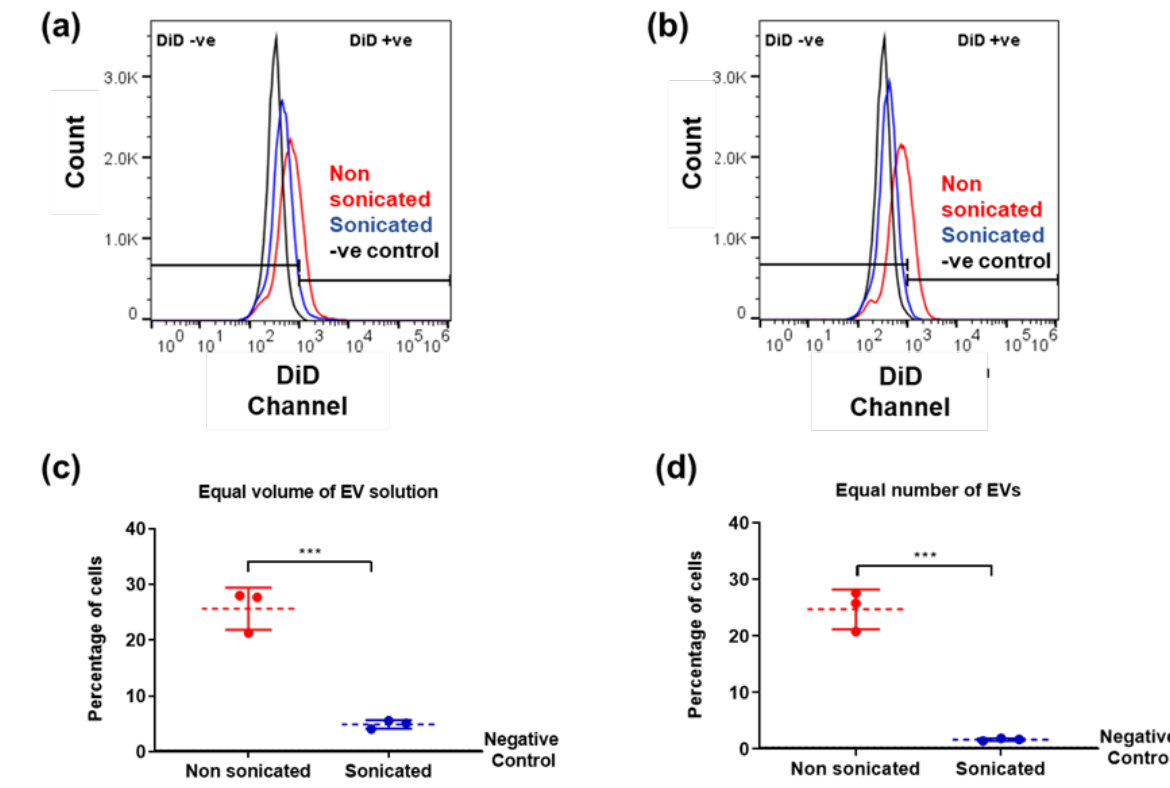
Figure 4. Flow cytometry analysis of EV uptake. DiD labelled EVs added at 0.5 µ L/cm 2 ( a , c ) or 1 × 10 9 particles/cm 2 ( b , d ). ( a , b ) Fluorescence detected in live cells after EV incubation compared to negative control (MSCs with no EVs added). ( c , d ) Quantification of cells containing EVs after incubation (red: non sonicated, blue: sonicated samples). Data analysis was performed with FlowJo v10.5 software (https://www.flowjo.com/) (accessed on 8 November 2018). N = 3, unpaired students t-test, two-tailed non-parametric; *** p < 0.001.